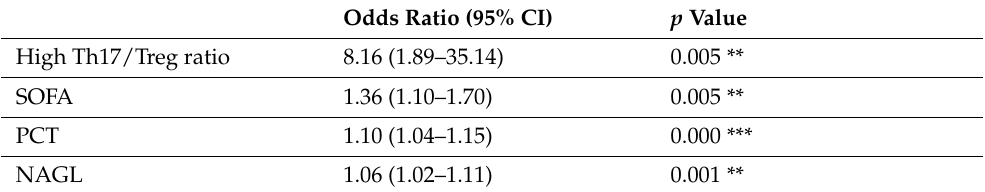
Figure 5. General outcomes between the high-Th17/Treg-ratio (>0.06967) group and the low- Th17/Treg-ratio ( ≤ 0.06967) group, including the comparison of incidence of SAKI ( A ), 28-day mortality ( B ), expenses of ICU ( C ), ICU length of stay ( D ), LOS ( E ). SAKI, sepsis-induced acute kidney injury; LOS, hospital length of stay; ICU, intensive care unit. p value: ns > 0.05; ***< 0.001. Table 3. Multivariable logistic regression of reclassification by cutoff value of Th17/Treg